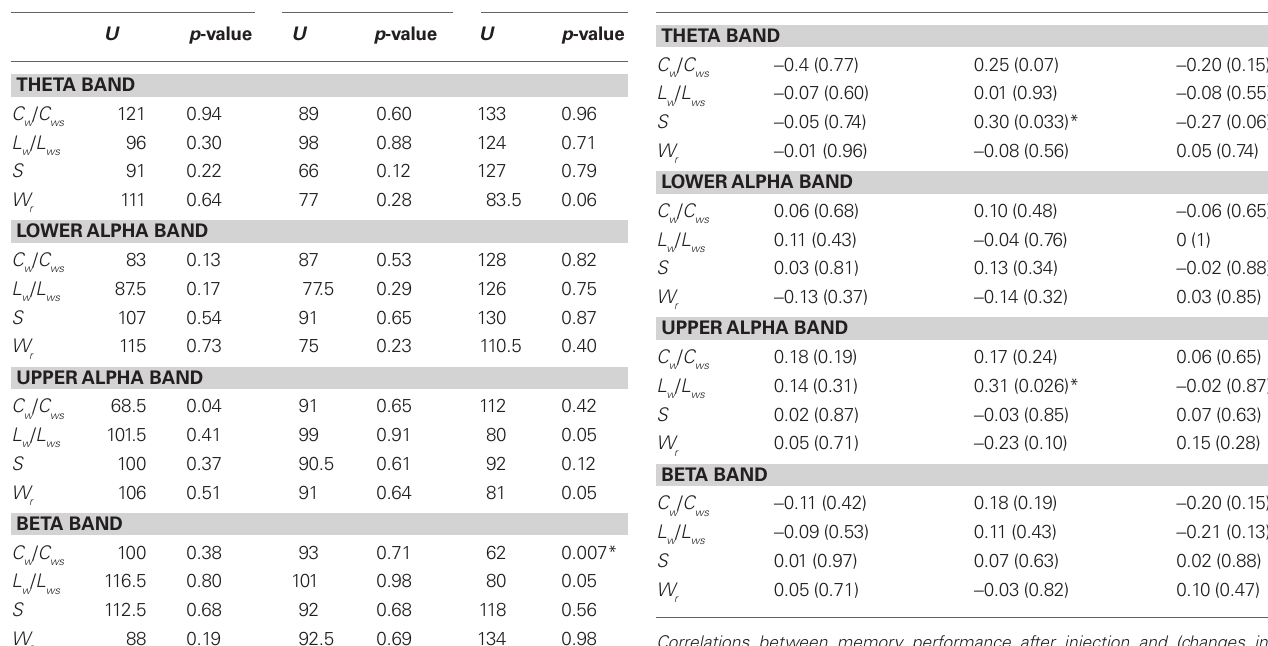
Correlations between memory performance after injection and (changes in) network characteristics: Kendall’s tau (p-value). Before injection = network charac- teristics during rest, before injection of amobarbital, During injection = network characteristics during unilateral sedation, Deltascore = network characteristic value after injection subtracted from network characteristic before injection, C /C = normalized clustering coefficient, L /L = normalized path length, w ws w ws S = small-world index, W = normalized edge weight correlation. All p-values r are uncorrected, “*” indicate significance without correction for multiple comparisons.